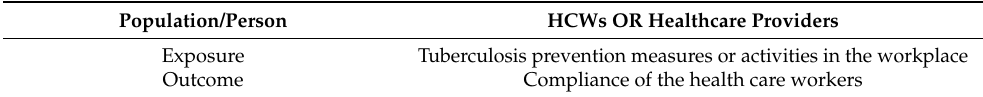
Table 1. PICO strategy in developing research question.